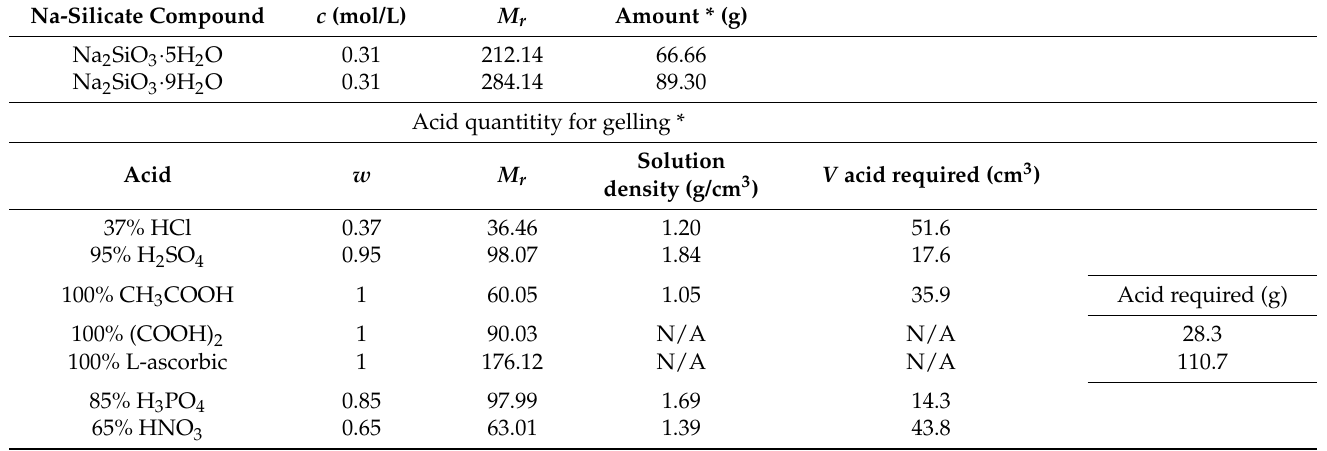
Table 1. Quantities of Na-silicate and appropriate amounts of some common acids for the fabrication of silica